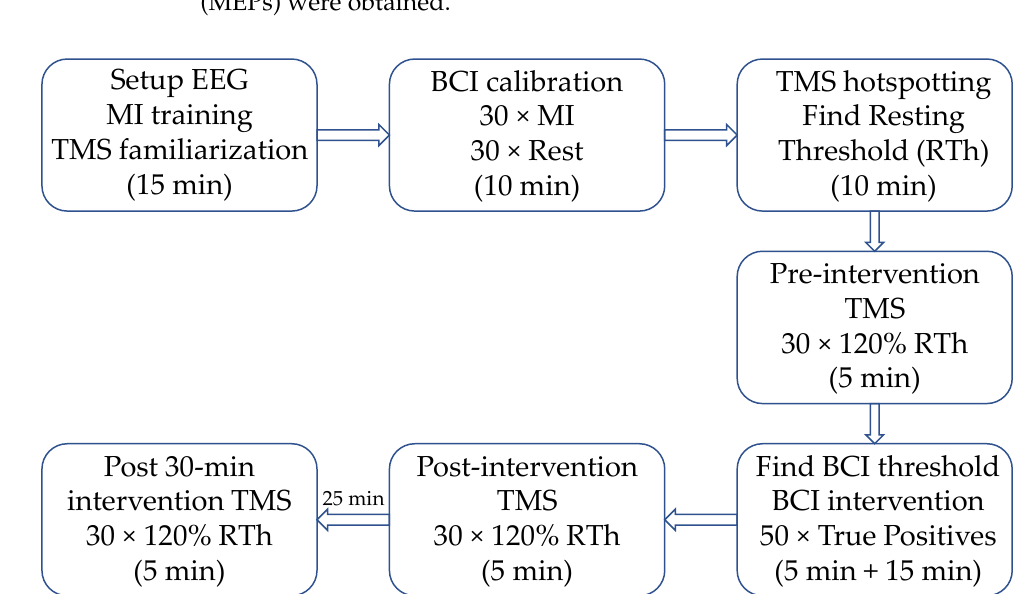
Figure 1. Timeline of the experiment; the approximate duration of each block is indicated in parentheses. First, the subject was familiarized with transcranial magnetic stimulation (TMS) and motor imagination (MI), and the EEG cap was mounted. Next, the brain-computer interface (BCI) was calibrated, followed by the identification of the optimal stimulation site (hotspot) and intensity (RTh). The pre-intervention TMS, post-intervention TMS, and post-30 min intervention TMS were identical. After the pre-intervention TMS, the threshold for each subject was tested with an online BCI and changed if needed. Afterwards, the intervention started, and it was stopped when the subject reached 50 correct pairings between motor imagination (MI) and movement of the exoskeleton. The post-30 min intervention TMS started 30 min after the BCI intervention